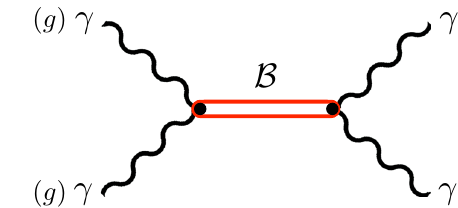
Fig. 9 Diagram for the bound state production and decay into the diphoton channel, pp → B →